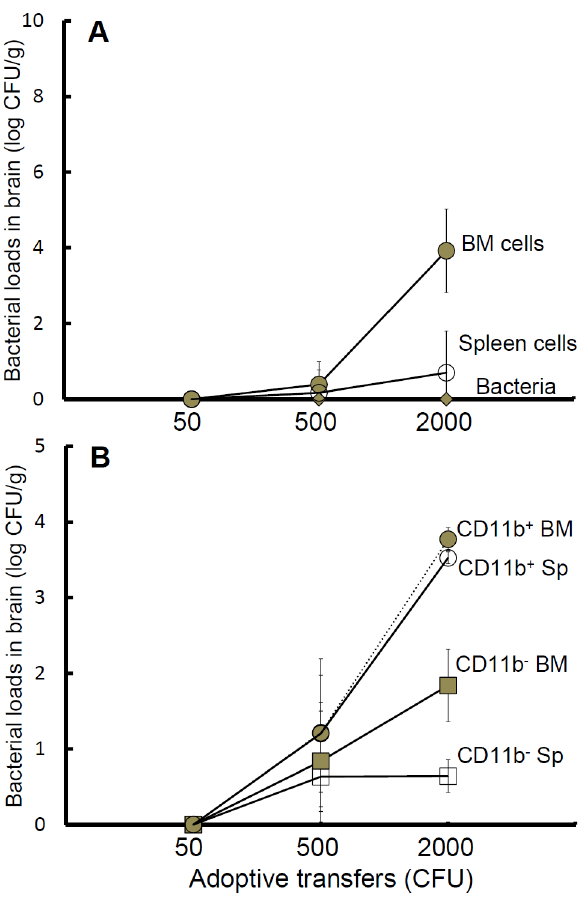
Figure 5. Adoptive transfers of infected cells. On day 10 post- infection, splenic (hollow circle) and BM (gray circle) cells were isolated and were adjusted to normalize the numbers (50, 500 or 2000 CFU) of intracellular B. pseudomallei . Extracellular (free) B. pseudomallei (50, 500 or 2000 CFU; gray diamond) were obtained from destroyed BM cells (A). Simultaneously, CD11b + and CD11b 2 cells were isolated from the spleen (hollow circle, CD11b + ; hollow square, CD11b 2 ) and BM (gray circle, CD11b + ; gray square, CD11b 2 ) (B). Two days after adoptive transfer, bacterial burdens (CFU/g) in the brain were determined in the recipients (n=3, independent duplicate experiments). The limits of detection were 3 CFU/g for brain tissue.